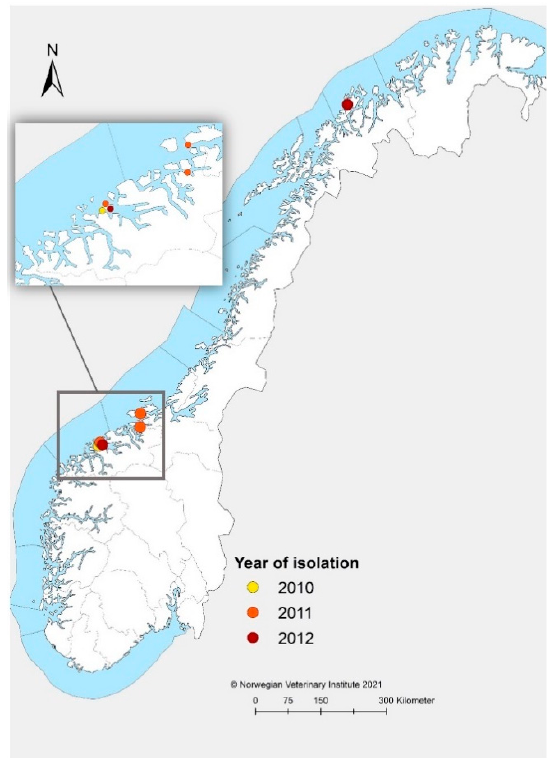
Figure 1. Map showing the geographical location of the six Norwegian sites included in this study. The colored dots represent year of SAV detection at each site. The enlarged window represents farms in Møre and Romsdal County and Trøndelag, while the farm in the northern part of the country is situated in